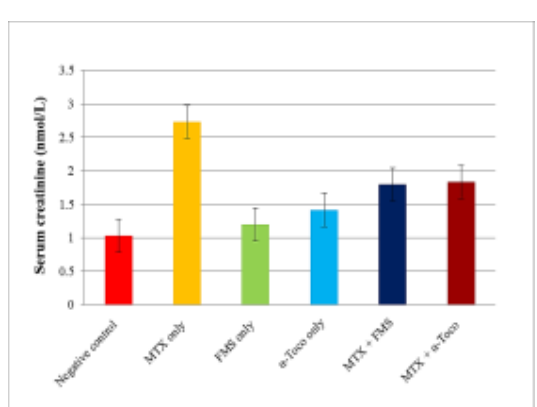
Figure 1.Effects of fimasartan on the serum levels of BUN.